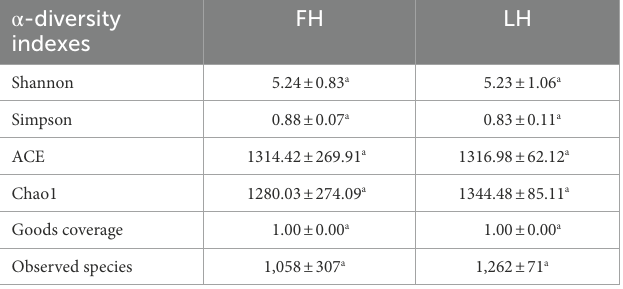
TABLE 3 α -diversity indexes of bacterial communities in Jinhua FH and LH. α -diversity indexes